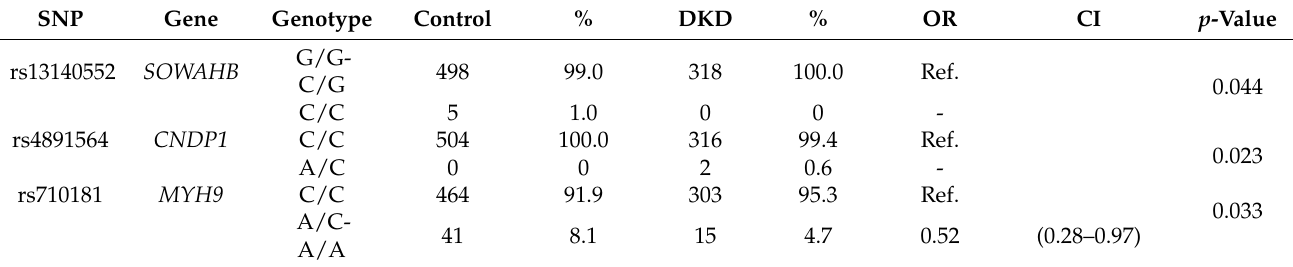
Table 4. Adjusted risk analysis of replicated genetic variants with diabetic kidney disease. SNP Gene